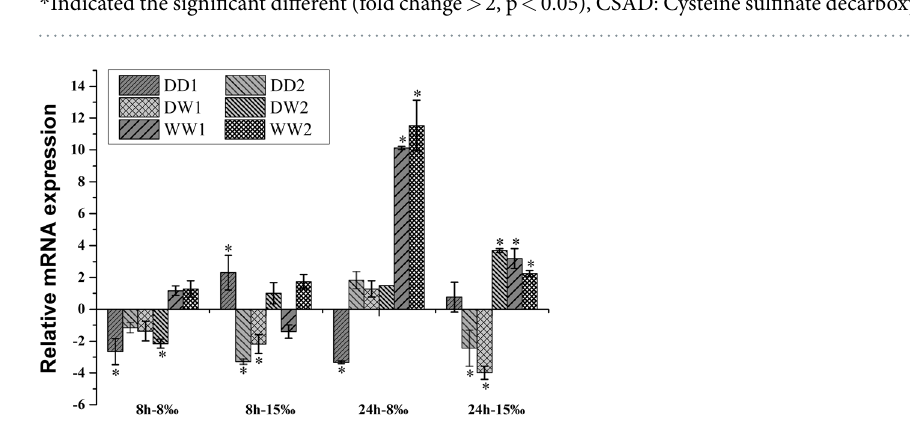
Figure 3. Relative mRNA expression of CgCSAD2 in different families of juvenile oyster under low osmotic stress. Elongation factor (EF) gene expression was used as internal control. The samples acclimated in 30‰ for 8 hours and 24 hours are the reference samples, respectively. The y-axis represent the fold changes between the expressions of treated samples and reference samples. Vertical bars represent the mean ± SD (N = 6). * Indicated the significant different (fold change > 2, p < 0.05), CSAD: Cysteine sulfinate